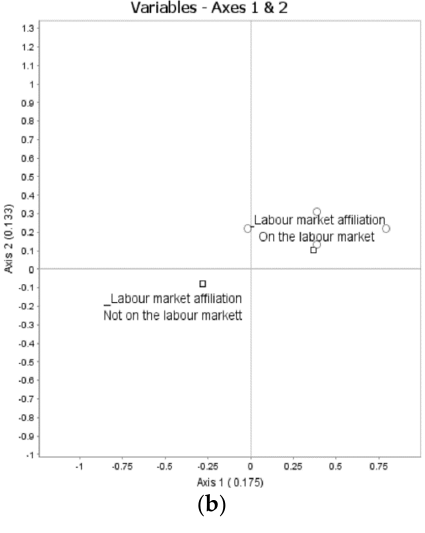
Figure 1. Space of active ageing indicators, Axes 1 and 2. Only response categories with above-average contribution values to one or both axes.